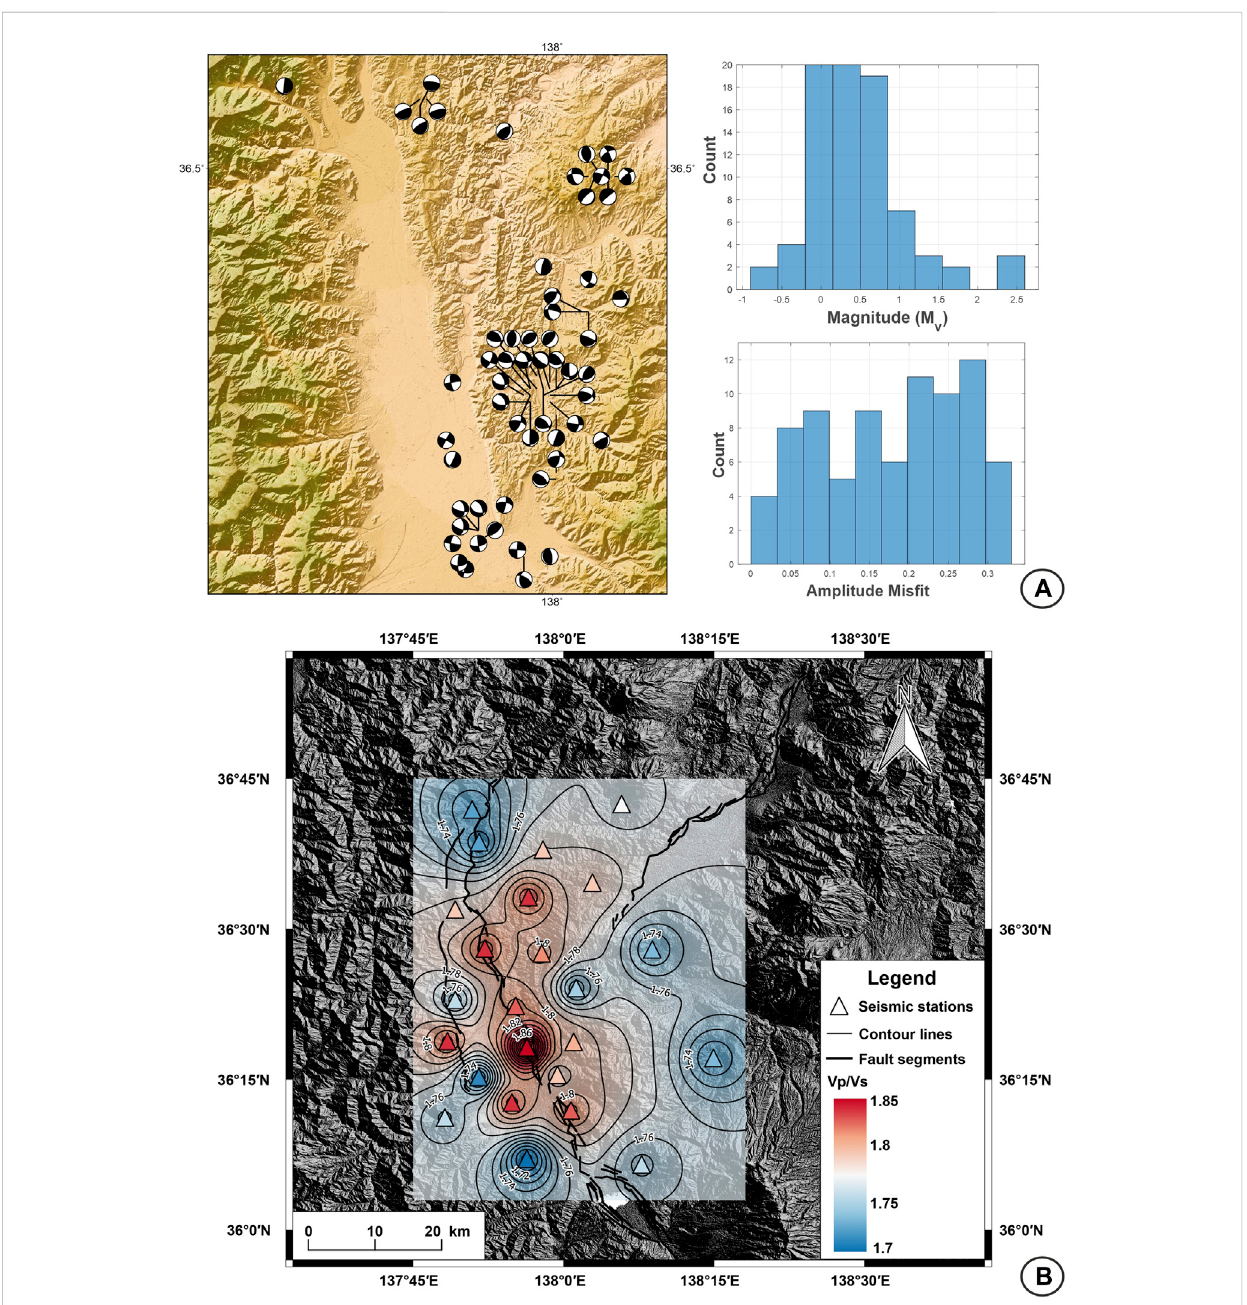
FIGURE 9 (A) On the left: plot of our focal mechanism solutions for the Nagano region with at least six P-wave readings. On the right: histograms of the magnitudedistributionandoftheP-waveamplitudemis fi tsforthecomputedfaultplanesolutions. (B) SpatialdistributionoftheV P /V S ratiointheNagano region. The ratios, computed at each seismic station (triangles) and interpolated, are indicated by the contour lines and